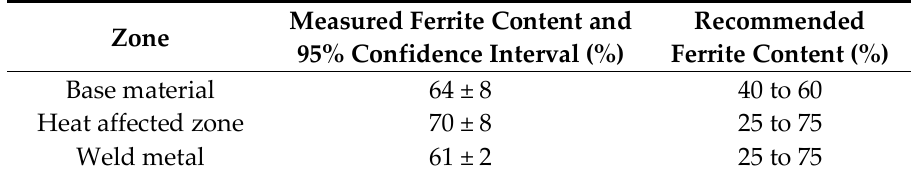
Table 2. Measured and recommended ferrite contents for the EN 1.4062 material in different zones of the welded